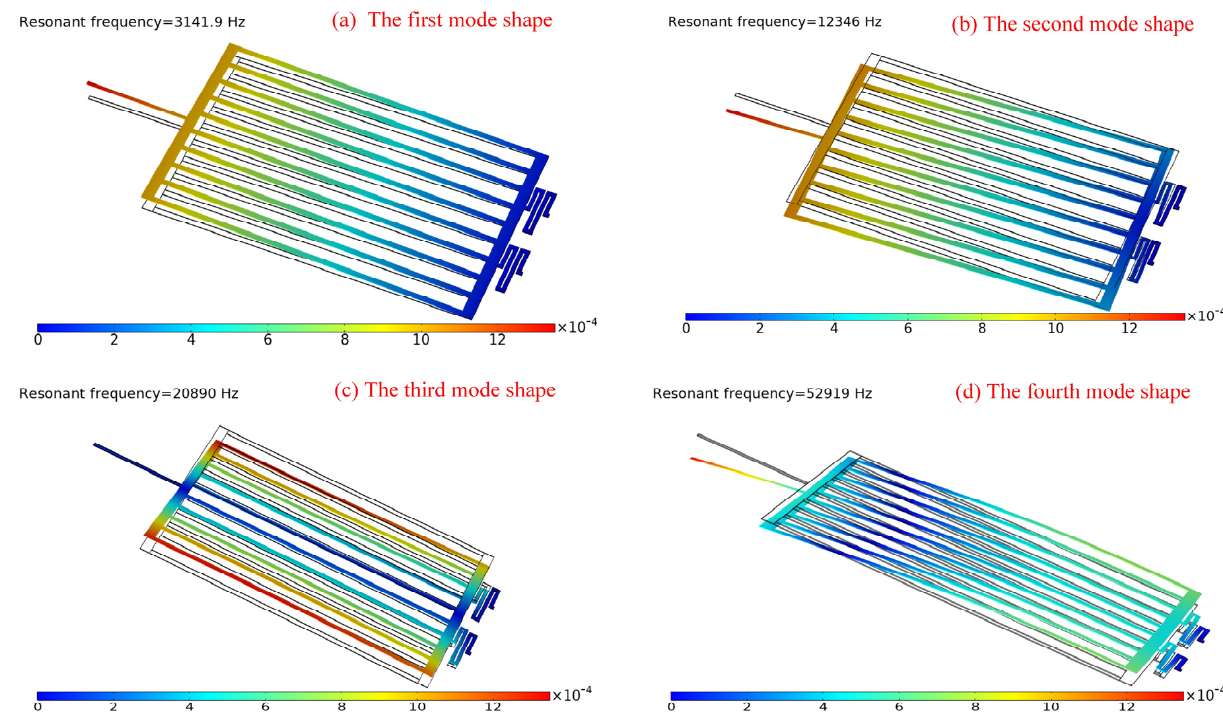
Figure 17. The mode shapes of the microgripper for the first four natural frequencies: ( a ) 3141.9 Hz, ( b ) 12,346 Hz, ( c ) 20,890 Hz and ( d ) 52,919 Hz.